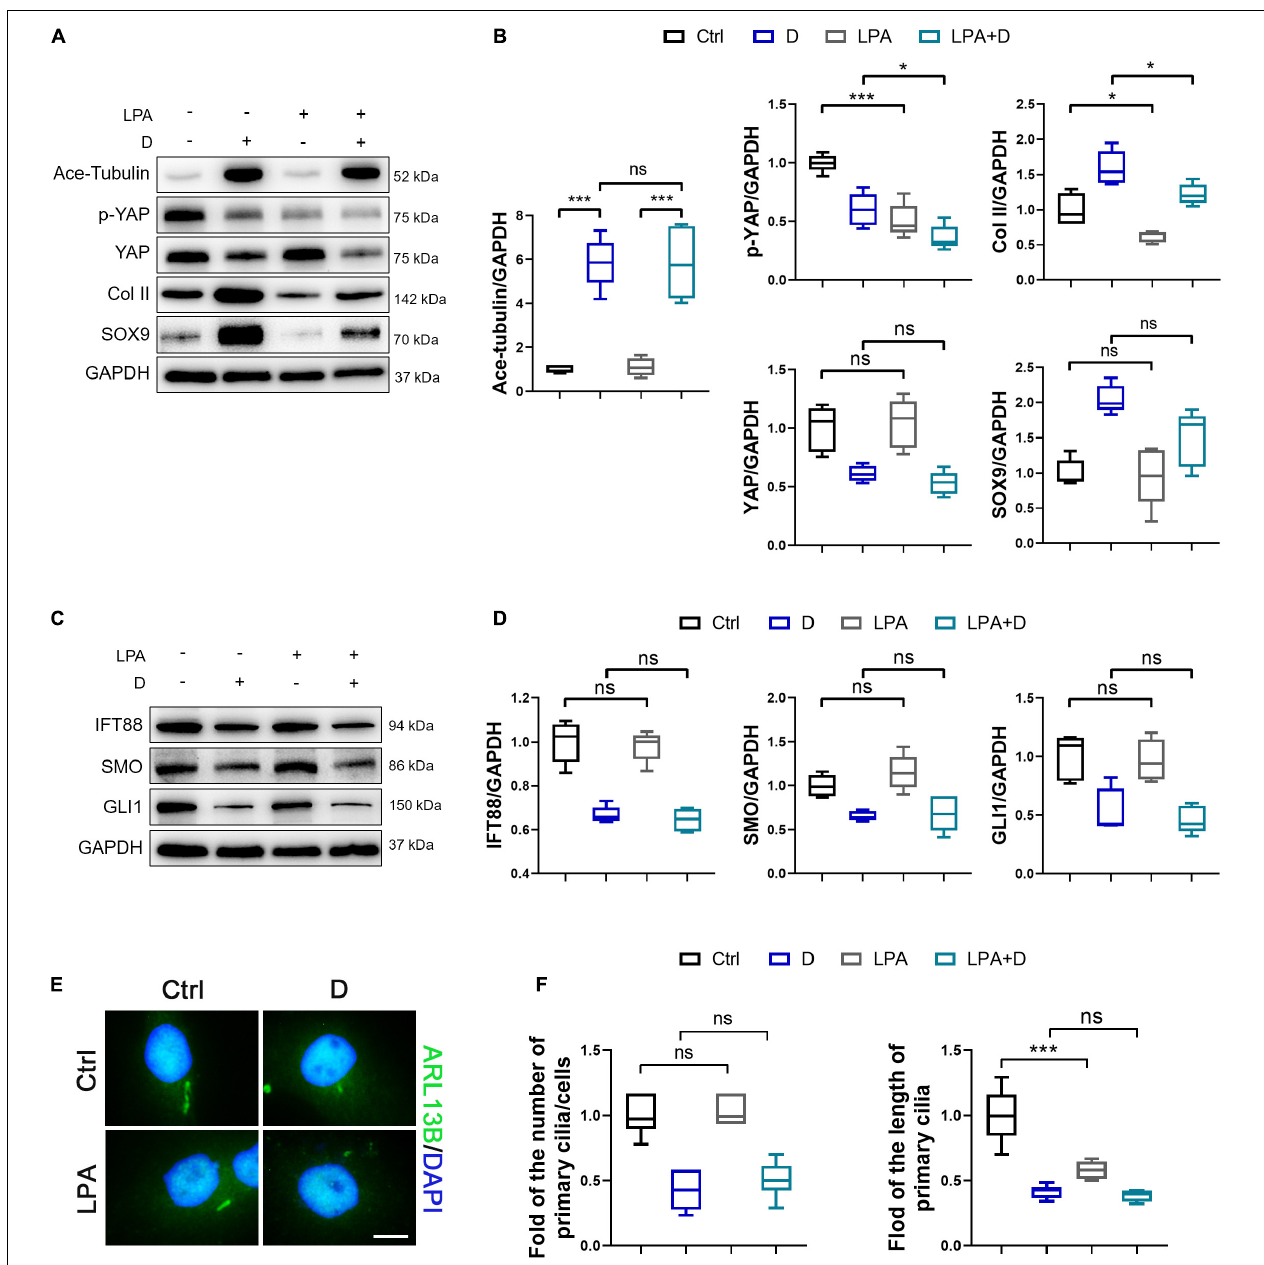
FIGURE 6 | Activation of YAP diminishes chondrogenesis and cilium elongation in SMSCs. (A) Western blot analysis of Ace-Tubulin, phosphorylated Yes-associated protein (YAP), YAP, Col II, and SOX9 in synovial mesenchymal stem cells (SMSCs) treated with lysophosphatidic acid (LPA) and treated with docetaxel (D) for 1 week. (B) Quantification of the data of (A) . n = 5. (C) Western blot analysis of IFT88, SMO, and GLI1 in SMSCs treated with lysophosphatidic acid (LPA) and treated with docetaxel (D) for 1 week. (D) Quantification of the data of (C) . n = 5. (E) Immunofluorescence staining for ARL13B in SMSCs. (F) Quantification of (E) for the number and length of primary cilia in SMSCs. n = 5. Data are represented as the mean ± SEM. * p < 0.05, *** p <